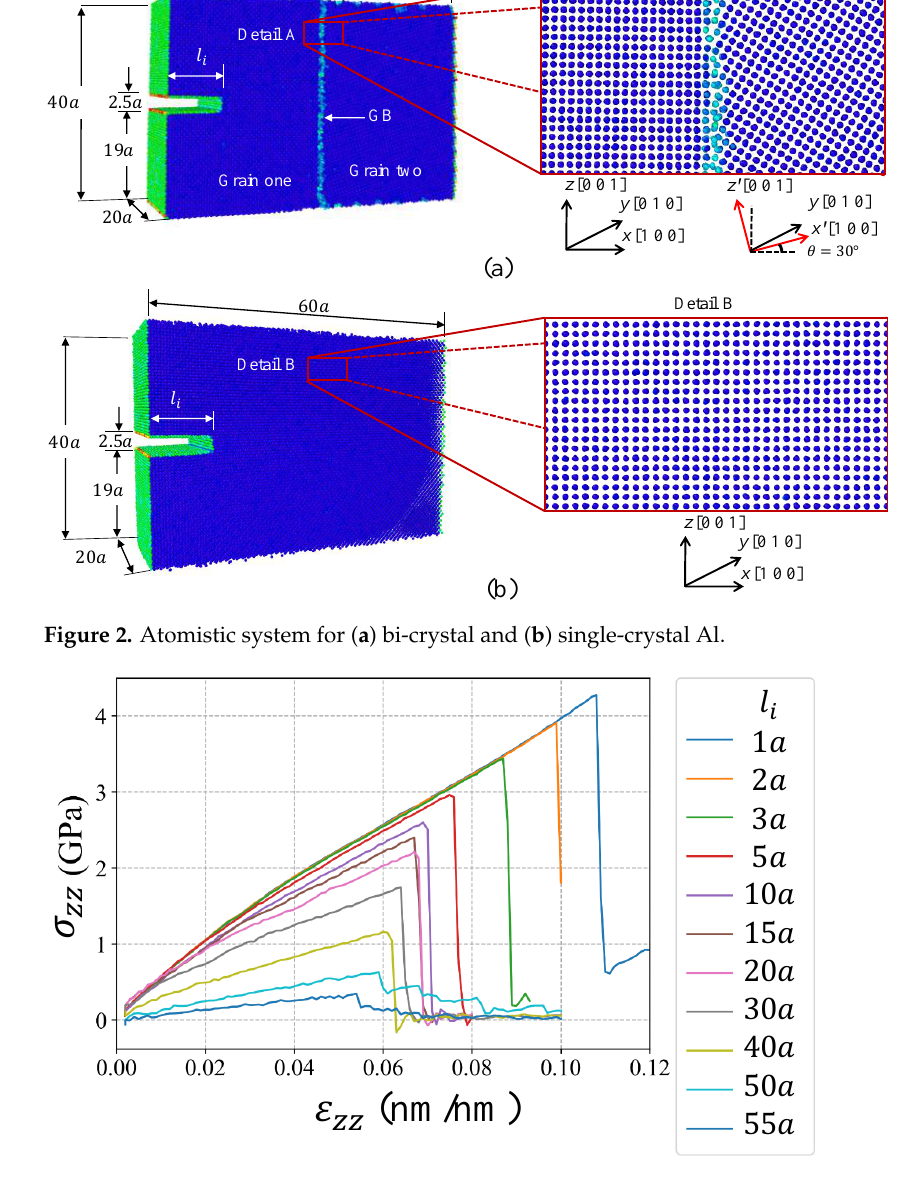
Figure 3. Simulation results of tensile tests for single-crystals Al with different l i